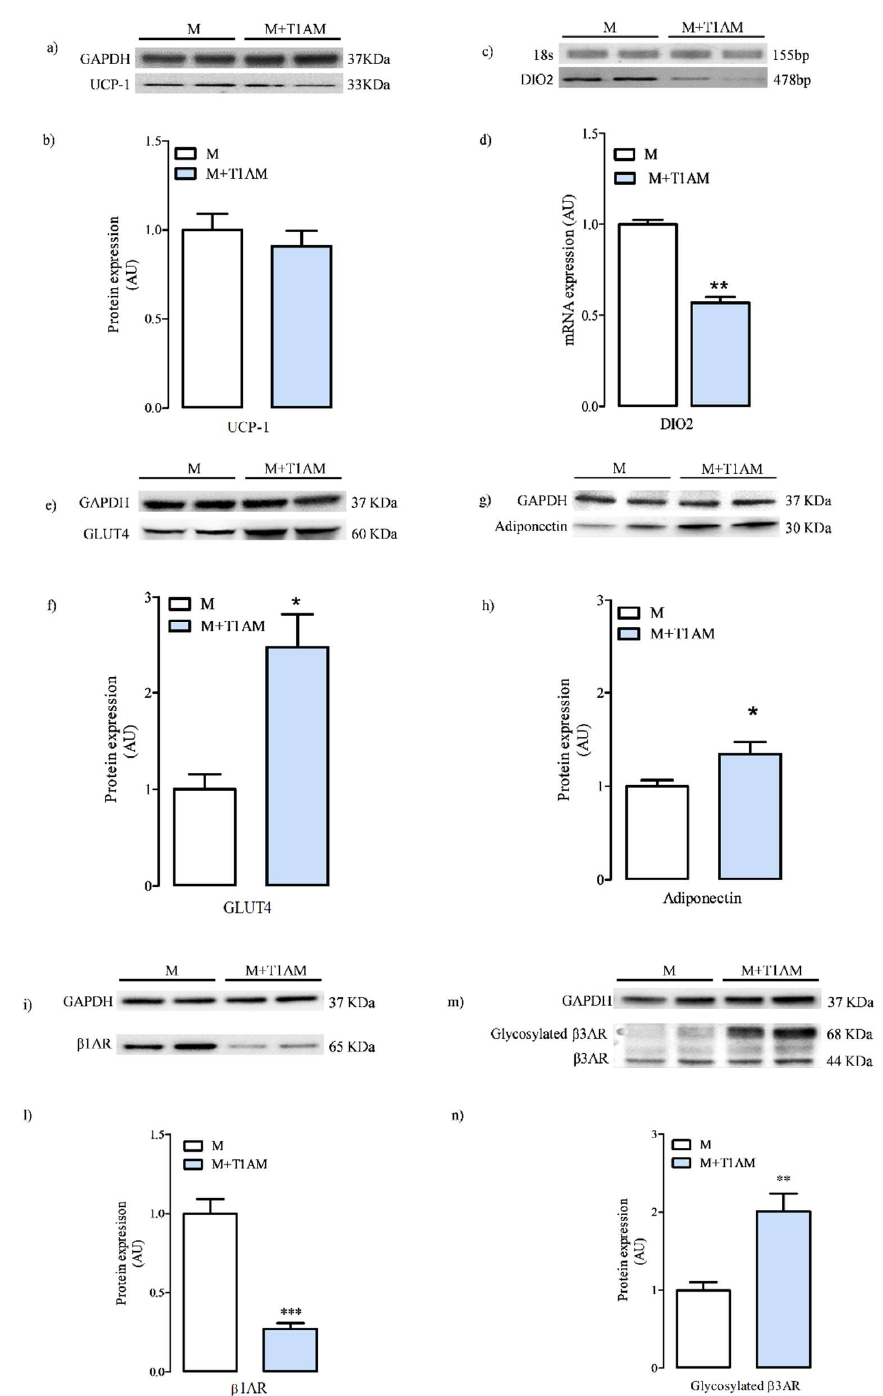
Figure 2. Di ff erentiation marker levels in M and M + T1AM cells. M and M + T1AM cells, obtained as described in the Material and Methods, were analyzed for the expression levels of UCP-1, type 2 deiodinase (DIO2), GLUT4, adiponectin, and type 1 and type 3 beta adrenergic receptors β 1- and β 3-AR by Western-blot analysis or semi-quantitative PCR, as described in the “Materials and Methods”. In Panels ( a , c , e , g , i,m ), representative experiments are shown. Each gel was loaded with the cDNA or with proteins obtained from two di ff erent cell preparations. ( b , d , f , h , l , n ). Densitometric analysis is reported as the mean ± standard error of the mean (SEM; n = 4 cell preparations) of arbitrary units (AU; see the Methods; * p < 0.05; ** p < 0.01; *** p < 0.001 vs. M